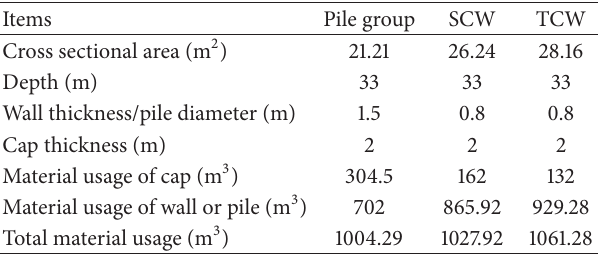
Table 1: Parameters of three